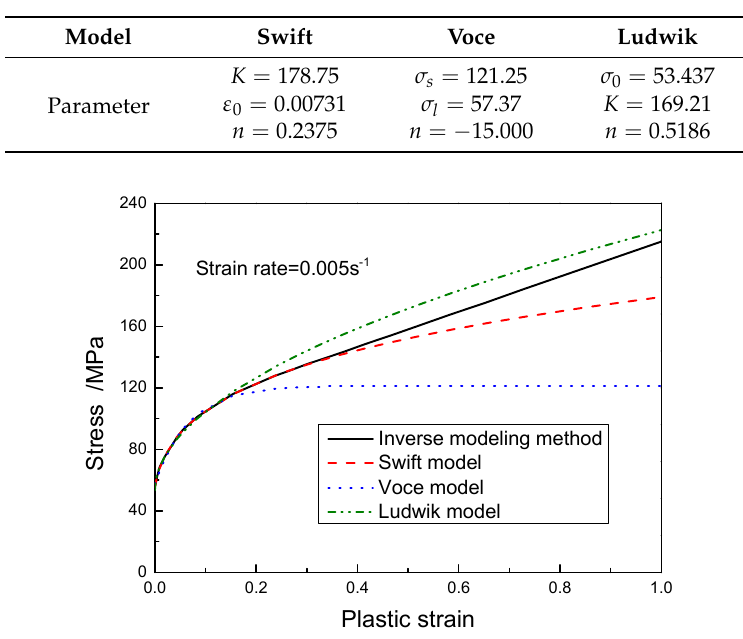
Figure 8. Extrapolation of three classical hardening laws. Table 3. Parameter values for each constitutive models.